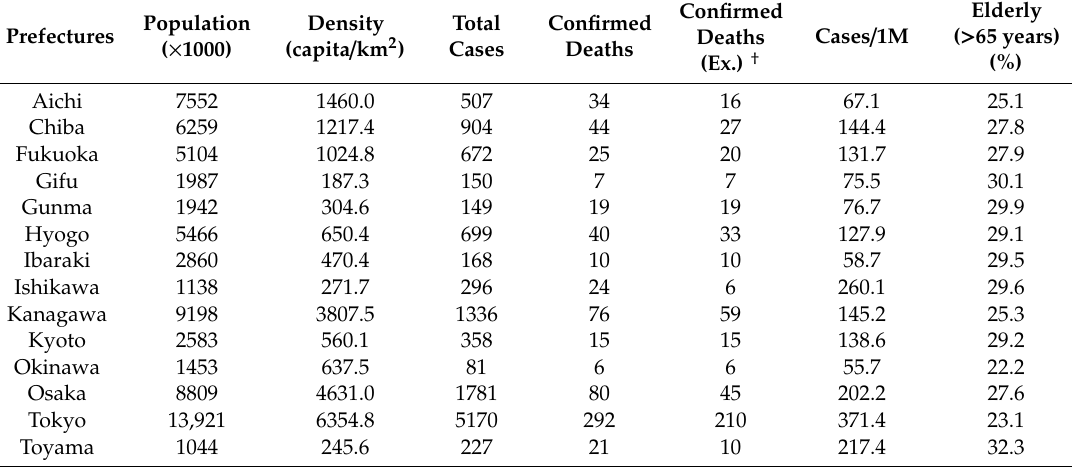
Table 1. Population and population density of 14 prefectures, in addition to the percentage of the elderly population, where confirmed deaths and daily confirmed positives are larger than 4 and 10, respectively. The data of confirmed cases and deaths were counted until 25 May 2020.